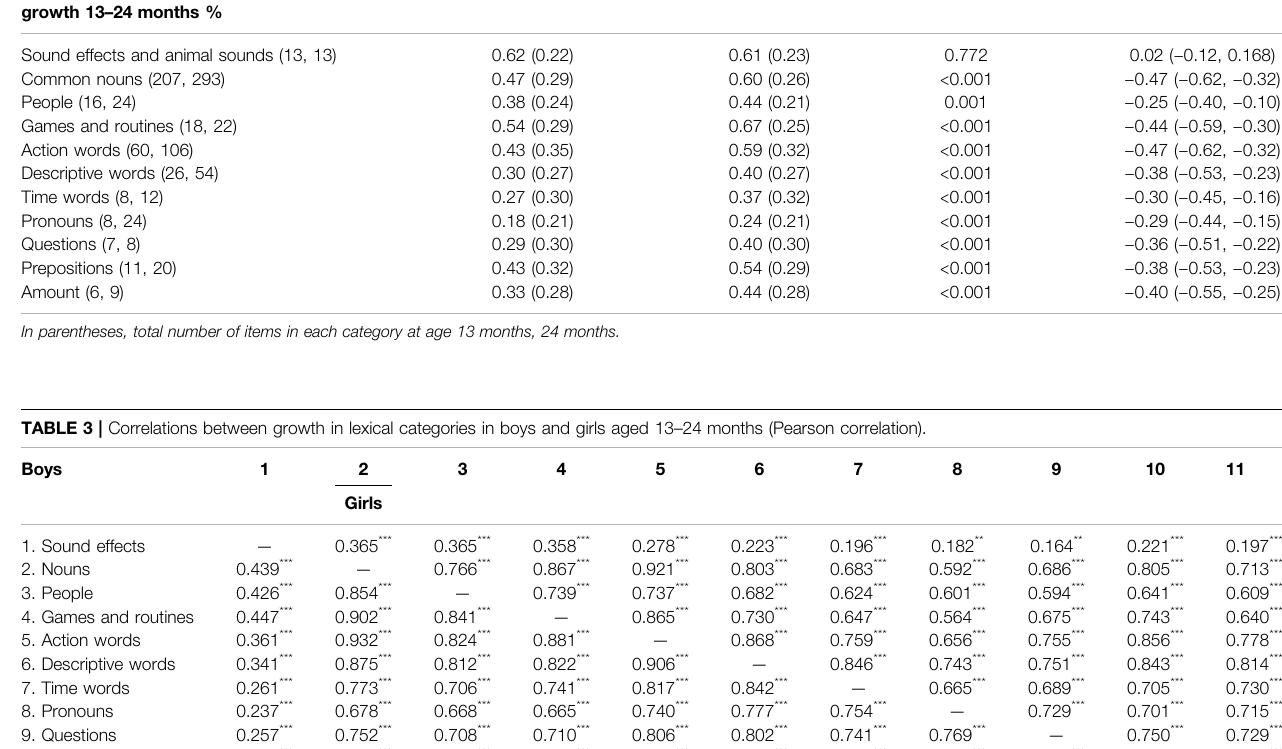
TABLE 2 | Descriptive statistics of mean vocabulary growth (in %) between ages 13 and 24 months for boys ( n (cid:1) 369) and girls ( n (cid:1) 350). Independent two-tailed t -test conducted when comparing mean differences between boys and girls. Lexical growth 13 – 24 months %